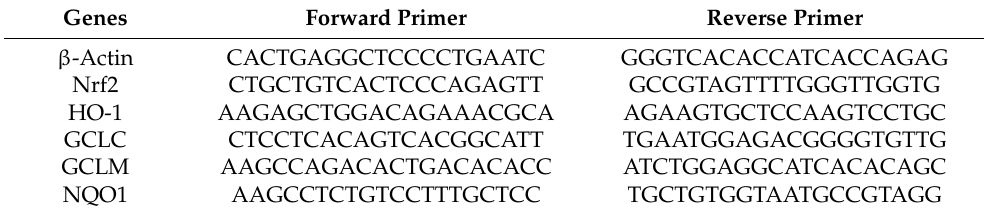
Table 1. Sequences of primers for quantitative real-time